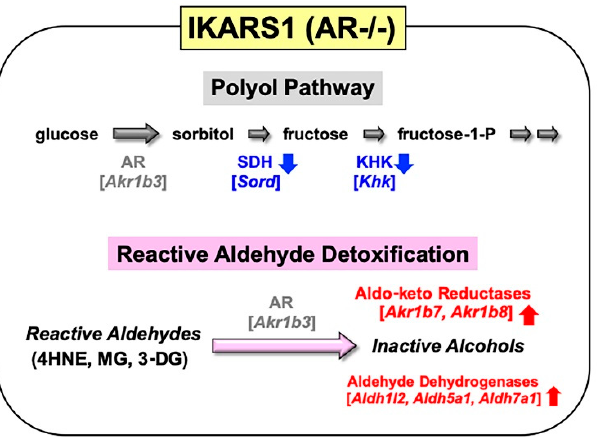
Figure 5. Establishment and characterization of IKARS1 cells. Marked down-regulation of polyol pathway-related enzymes (SDH, KHK) mRNA expression, and significant upregulation of aldo-keto reductases (AKR1B7, AKR1B8) and aldehyde dehydrogenases (ALDH1L2, ALDH5A1, ALDH7A1) mRNA expression in IKARS1 cells compared with those in 1970C3 cells. The upregulated enzymes might take over the AR detoxifying function. The genes encoding the respective enzymes are expressed as their abbreviations in square brackets.